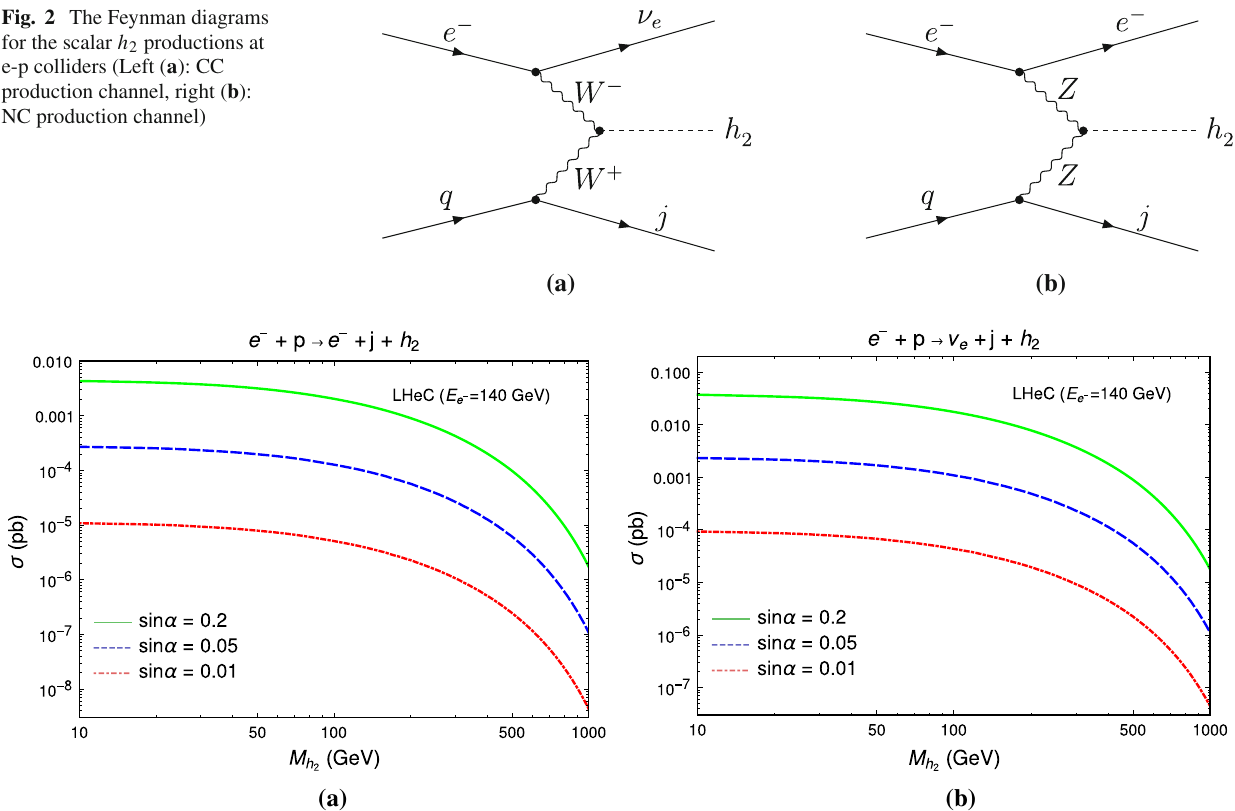
Fig. 3 The production cross sections of the processes e − p → e − jh 2 and e − p → ν e jh 2 as functions of the mass parameter M h (solid), 0 . 05 (dashed), 0 . 01 (dotted) and the beam polarization P ( e − ) = − 0 . 8 at the